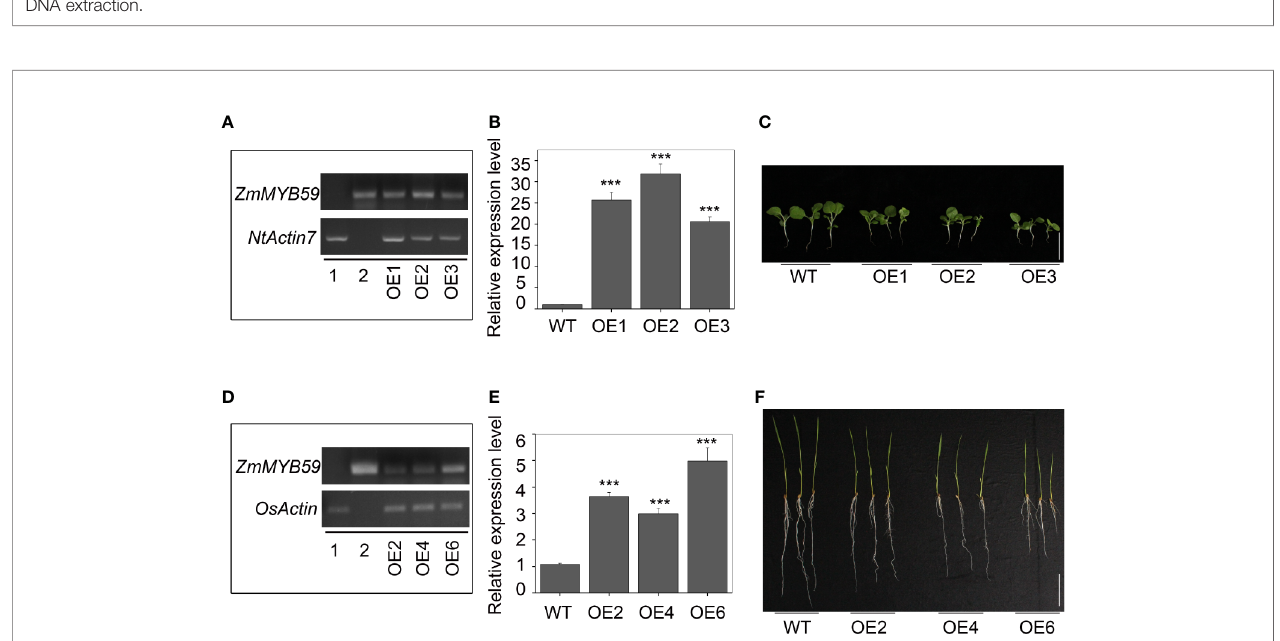
FIGURE 2 | ZmMYB59 inhibited seedling growth in tobacco and rice. (A, B) The expression of ZmMYB59 overexpressed tobacco was detected by semi- quantitative RT-PCR (A) or real time PCR (B) . RNA was extracted from T 2 generation transgenic tobacco. 1: WT; 2: vector used for transformation; OE-1, 2, 3: different lines of ZmMYB59 overexpressed tobacco. The expression of Ntactin7 was used as internal control. Values are means ± SD; n = 3. ***P < 0.001 (Student ’ s t-test). (C) Phenotype of ZmMYB59 overexpressed tobacco. The white scale bar represents 5 cm. (D, E) The expression of ZmMYB59 overexpressed rice was detected by semi-quantitative RT-PCR (D) or real time PCR (E) . RNA was extracted from T 2 generation transgenic rice. 1: WT; 2: vector used for transformation; OE-2, 4, 6: different lines of ZmMYB59 overexpressed rice. The expression of Osactin was used as internal control. Values are means ± SD; n = 3. ***P < 0.001 (Student ’ s t-test). (F) Phenotype of ZmMYB59 overexpressed rice. The white scale bar represents 5